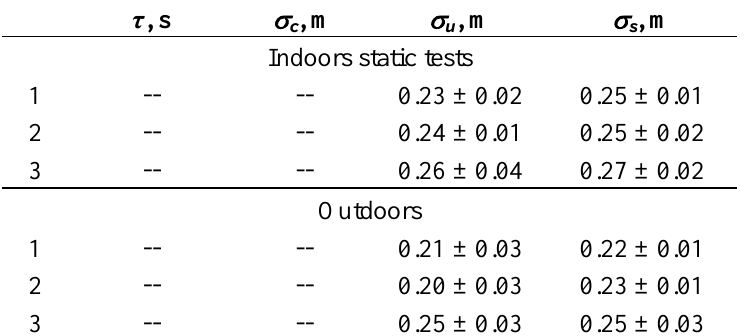
Table 4. ARMA model parameters (10% trimmed mean ± SD)—surrogate data, second